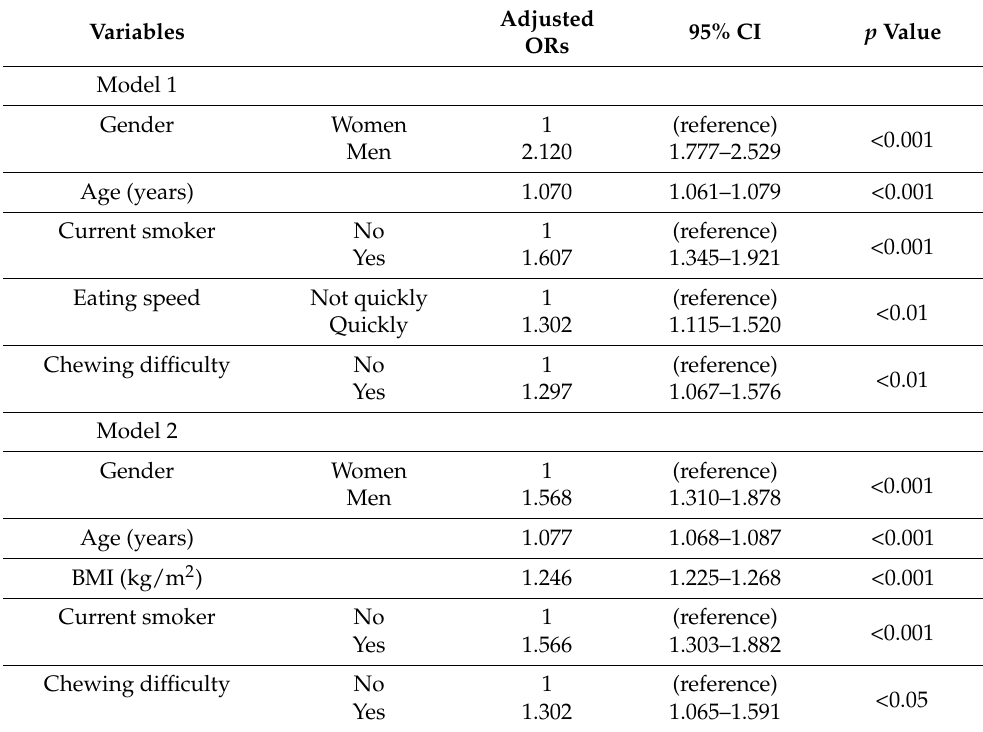
Adjusted 95% CI p Value ORs